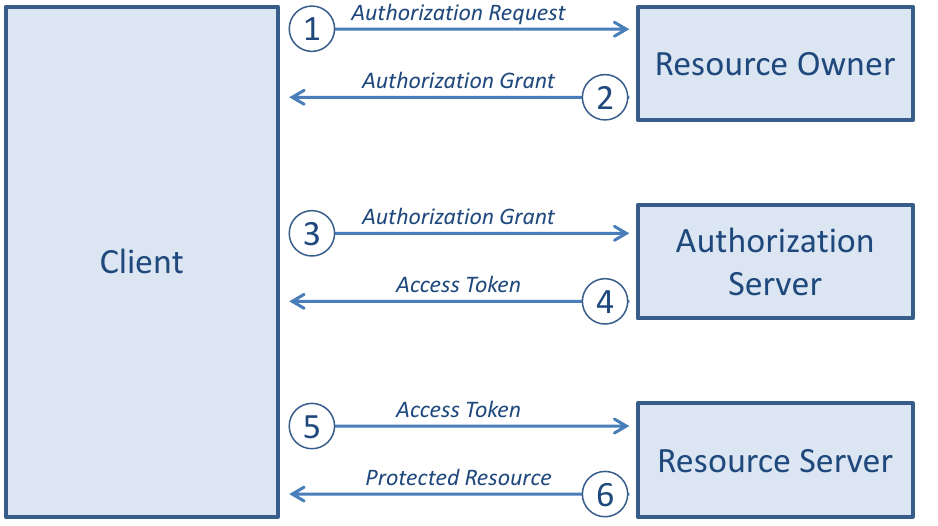
Figure 5. Interaction between the four roles of the OAuth protocol